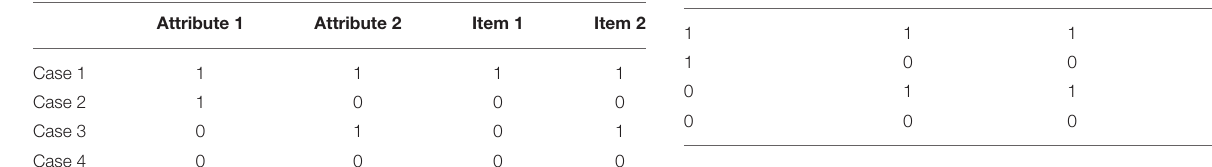
TABLE 2 | The ideal response pattern and the corresponding attribute profiles.